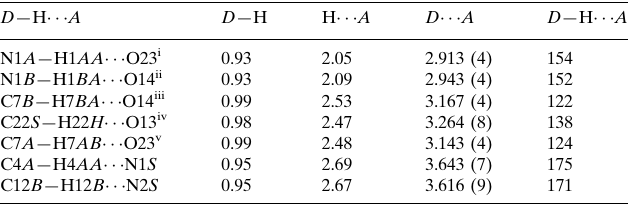
Hydrogen-bond geometry (A˚ , (cid:3)